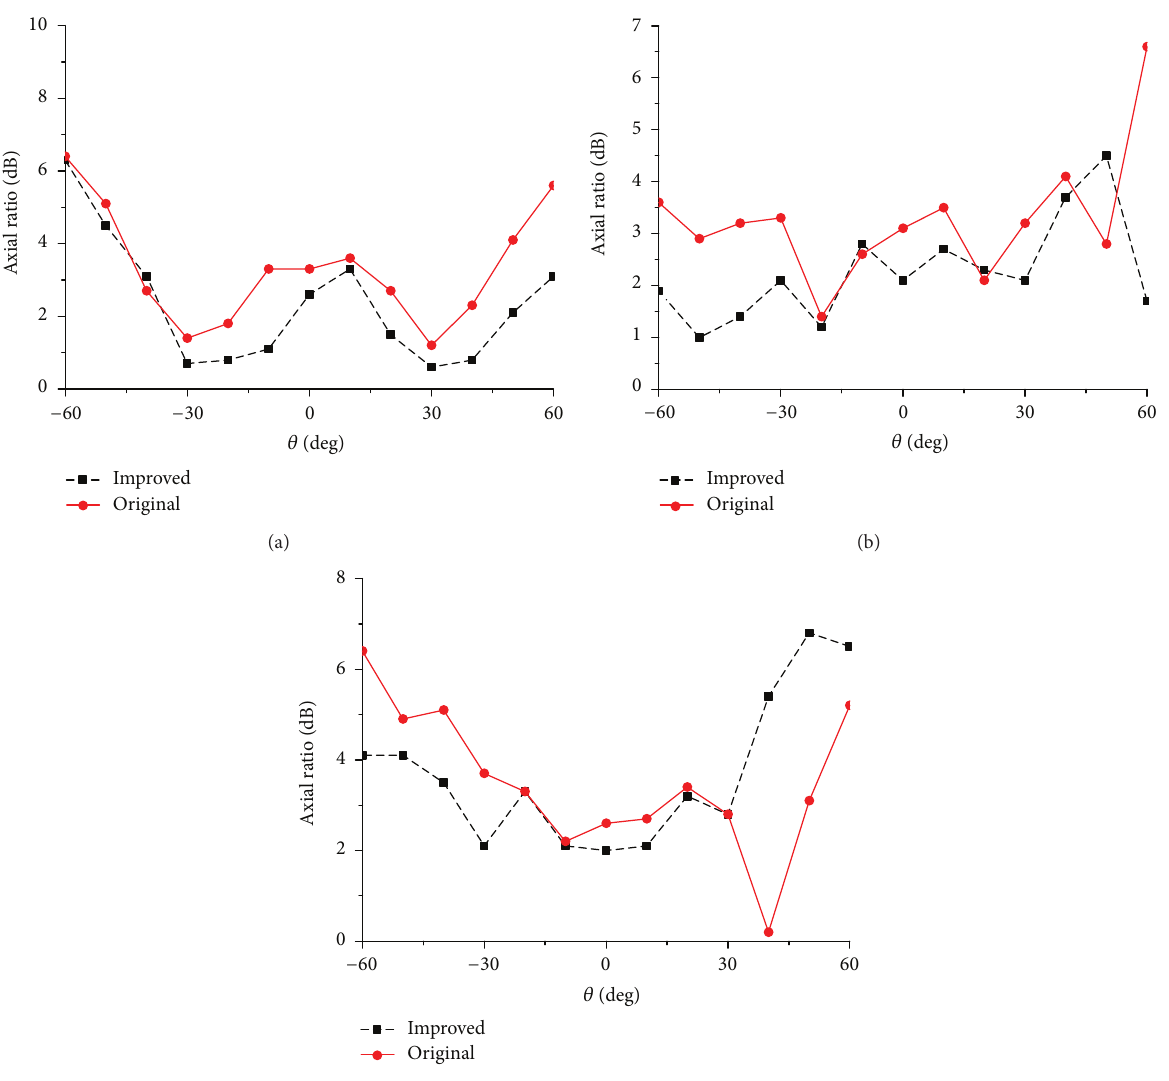
Figure 9: Axial ratio performances of the three components: (a) number 2 component, (b) number 4 component, and (c) number 6